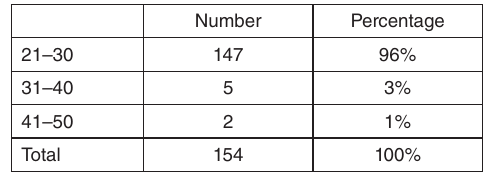
Table 2: Sample age distribution